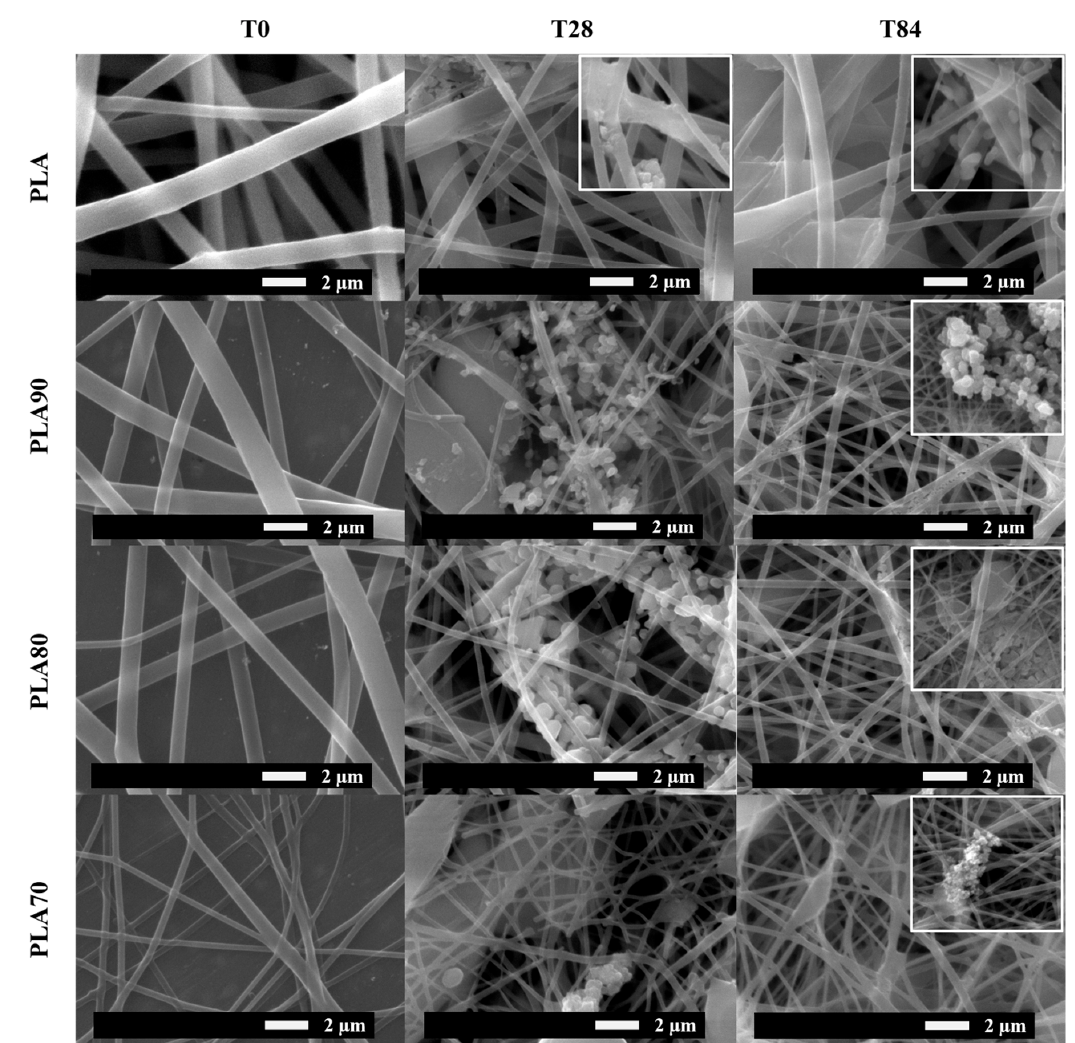
Figure 1. SEM images at 8000x of neat PLA and each PLA: OLA electrospun samples after 0, 28 and 84 days of immersion in PBS.